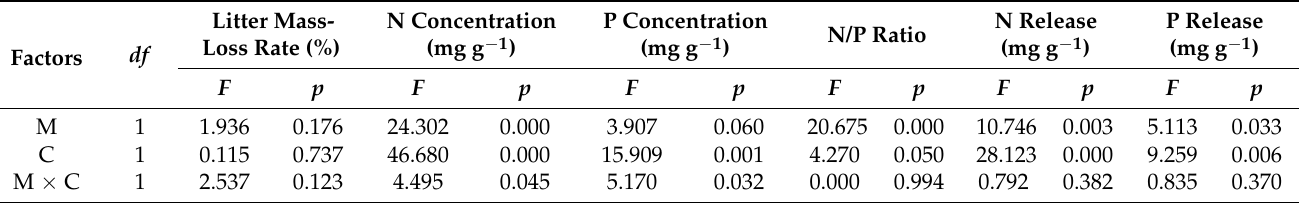
Figure 2. The biomass of B. papyrifera and C. pubescens seedlings through the treatments of competition pattern, AM fungus and with ( a , b ) or without ( c , d ) litter addition. Abbreviations: M + = with AM fungus; M − = without AM fungus; Intra − = intraspecific competition; Inter − = interspecific competition; the *, ** and *** mean different difference between Intra − and Inter − treatments under M + or M − at p < 0.05, p < 0.01 and p < 0.001, respectively; while the ‘ns’ means a not significant difference; the different lowercase letters (a,b) means a significant difference between M + and M − treatments under Intra − or Inter − ( p < 0.05). Table 2. Two-Way ANOVAs for the effects of AM fungus (M + vs. M − ) and competition pattern (Intra- vs. Inter-) on the concentrations and releases of nitrogen and phosphorus and N/P ratio in residual